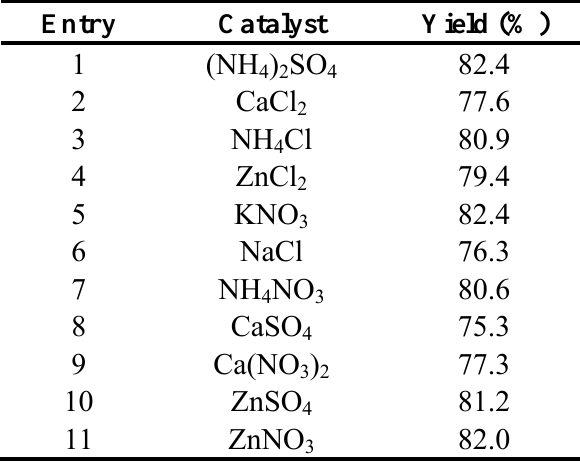
Table 3. Effect of catalyst on experimental